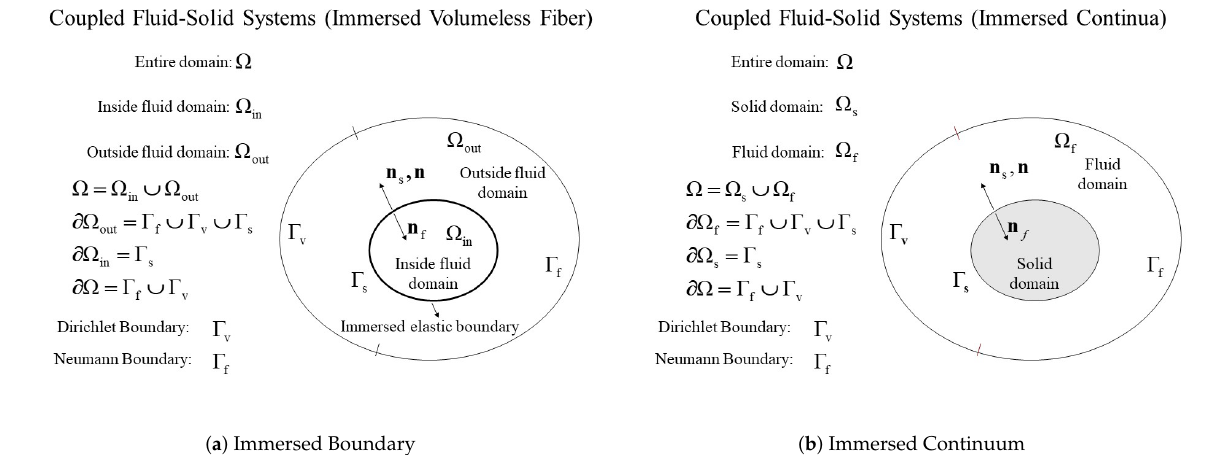
Figure 1. The concept of fictitious fluid domain vs. immersed domain.